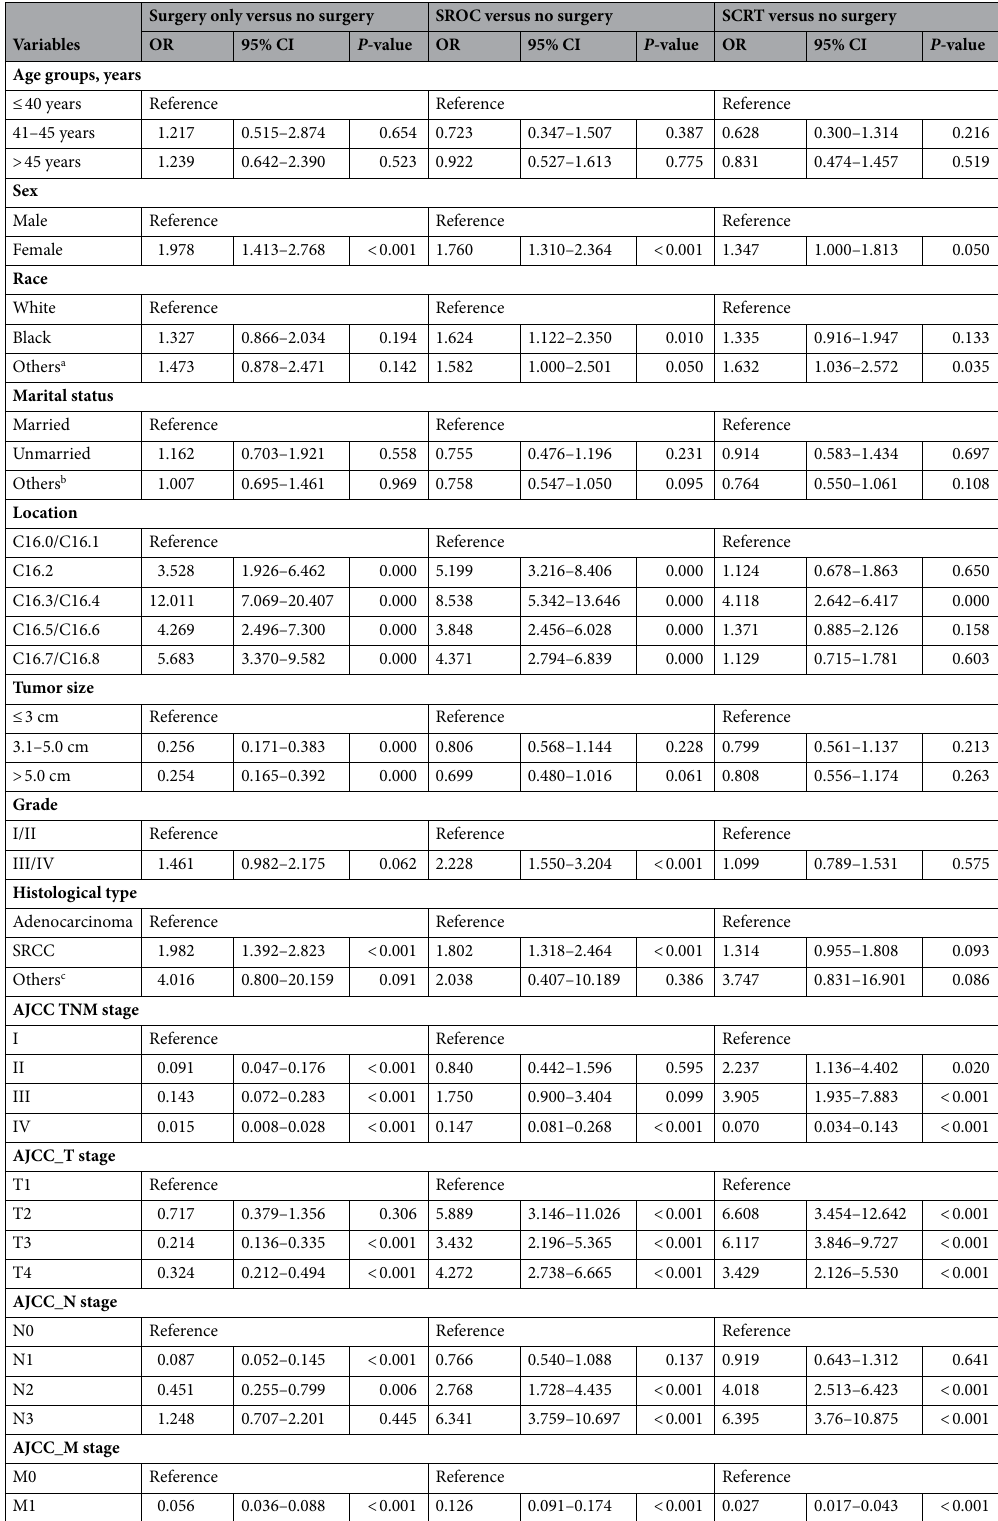
Table 2. Polytomous logistic regression for each treatment group (vs. no surgery) as the dependent variable of interest. Others a : American Indian/AK Native, Asian/Pacific Islander, unknown; Others b : Divorced, Separated, Widowed, unknown; SRCC: signet ring cell carcinoma; Others c : cystic, mucinous and serous neoplasms; SROC: surgery plus radiotherapy or chemotherapy; SCRT: surgery plus chemoradiotherapy; OR: odds ratio; CI: confidence Interval; C16.0/C16.1: Cardia, NOS/Fundus of stomach; C16.2: Body of stomach; C16.3/C16.4: Gastric antrum/ Pylorus; C16.5/C16.6: Lesser curvature of stomach NOS/Greater curvature of stomach NOS; C16.8/C16.9: Overlapping lesion of stomach/Stomach,